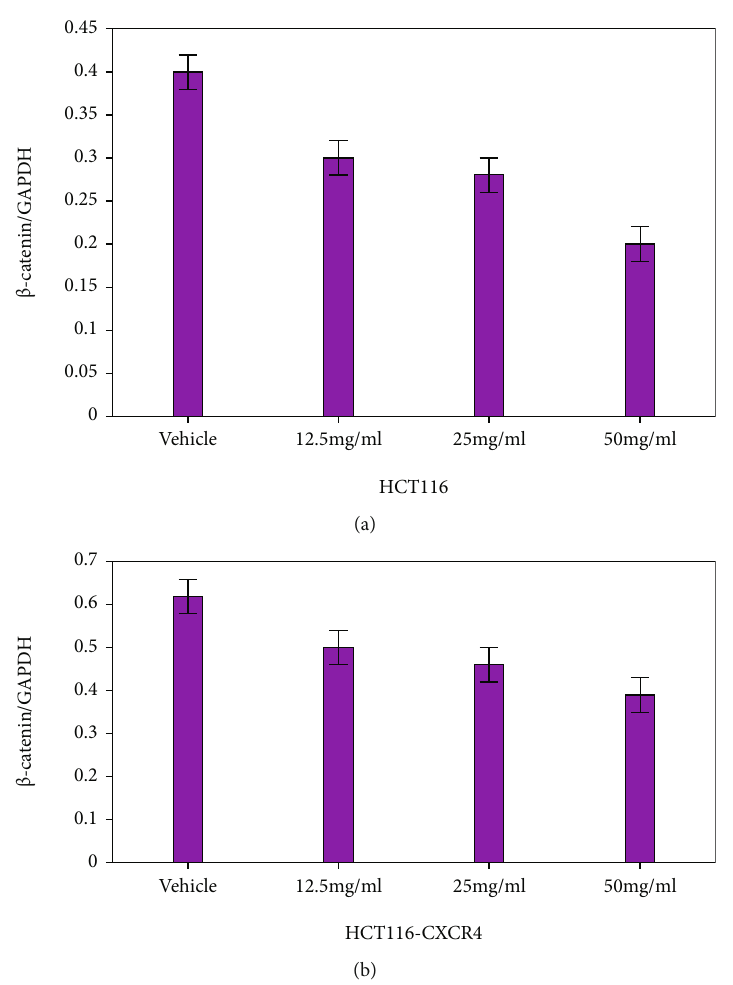
Figure 8: (a, b) E ff ect of HQEZ on β -catenin.